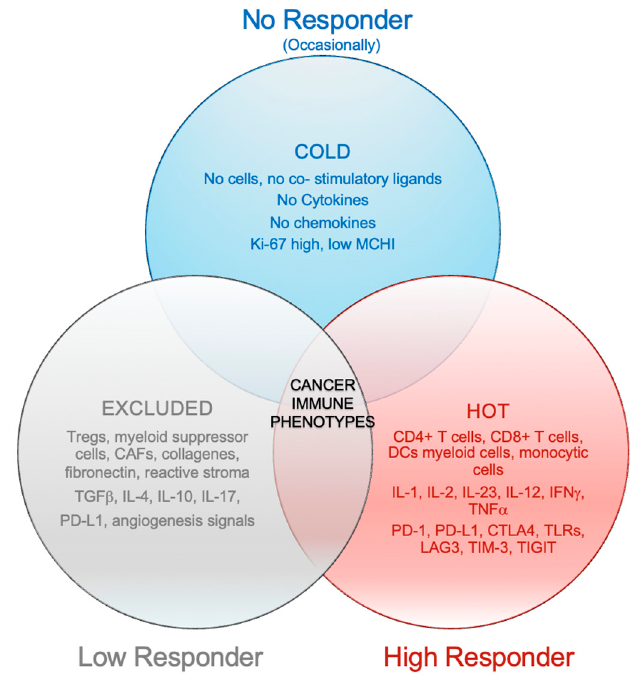
Figure 1. Cancer immune phenotypes.